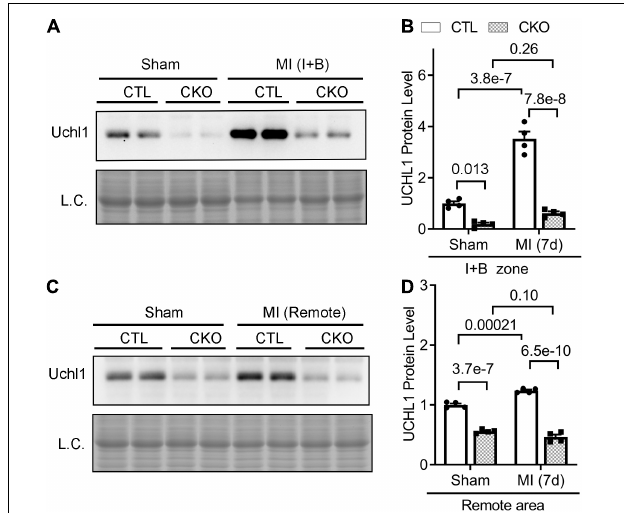
FIGURE 4 | Upregulation of myocardial Uchl1 in post-MI mice occurs primarily in cardiomyocytes. Myh6-Cre transgenic (CTL) mice and mice with cardiomyocyte-restricted knockout of Uchl1 (CKO) at 10 weeks of age were subjected to sham surgery (Sham) or permanent LAD ligation (MI). For protein analyses, ventricular myocardium was sampled from the infarct and boarder (I + B) zone (A,B) or the remote area (C,D) of the post-MI mice or the equivalent areas of the sham control mice 7 days (7d) after LAD ligation. (A,C) Representative images of Western blot analyses for Uchl1 in the peri-infarct area (Peri-IF, A ) and the remote zone (C) . L.C., loading control, which used the images from staining-free gel imaging technology. (B,D) Scatter plots superimposed by mean ± SEM to show the pooled densitometry data from four mice (two males and two females) per group. The p -value of the pair-wise comparison is shown above the bracket and is derived from two-way ANOVA followed by Tukey’s